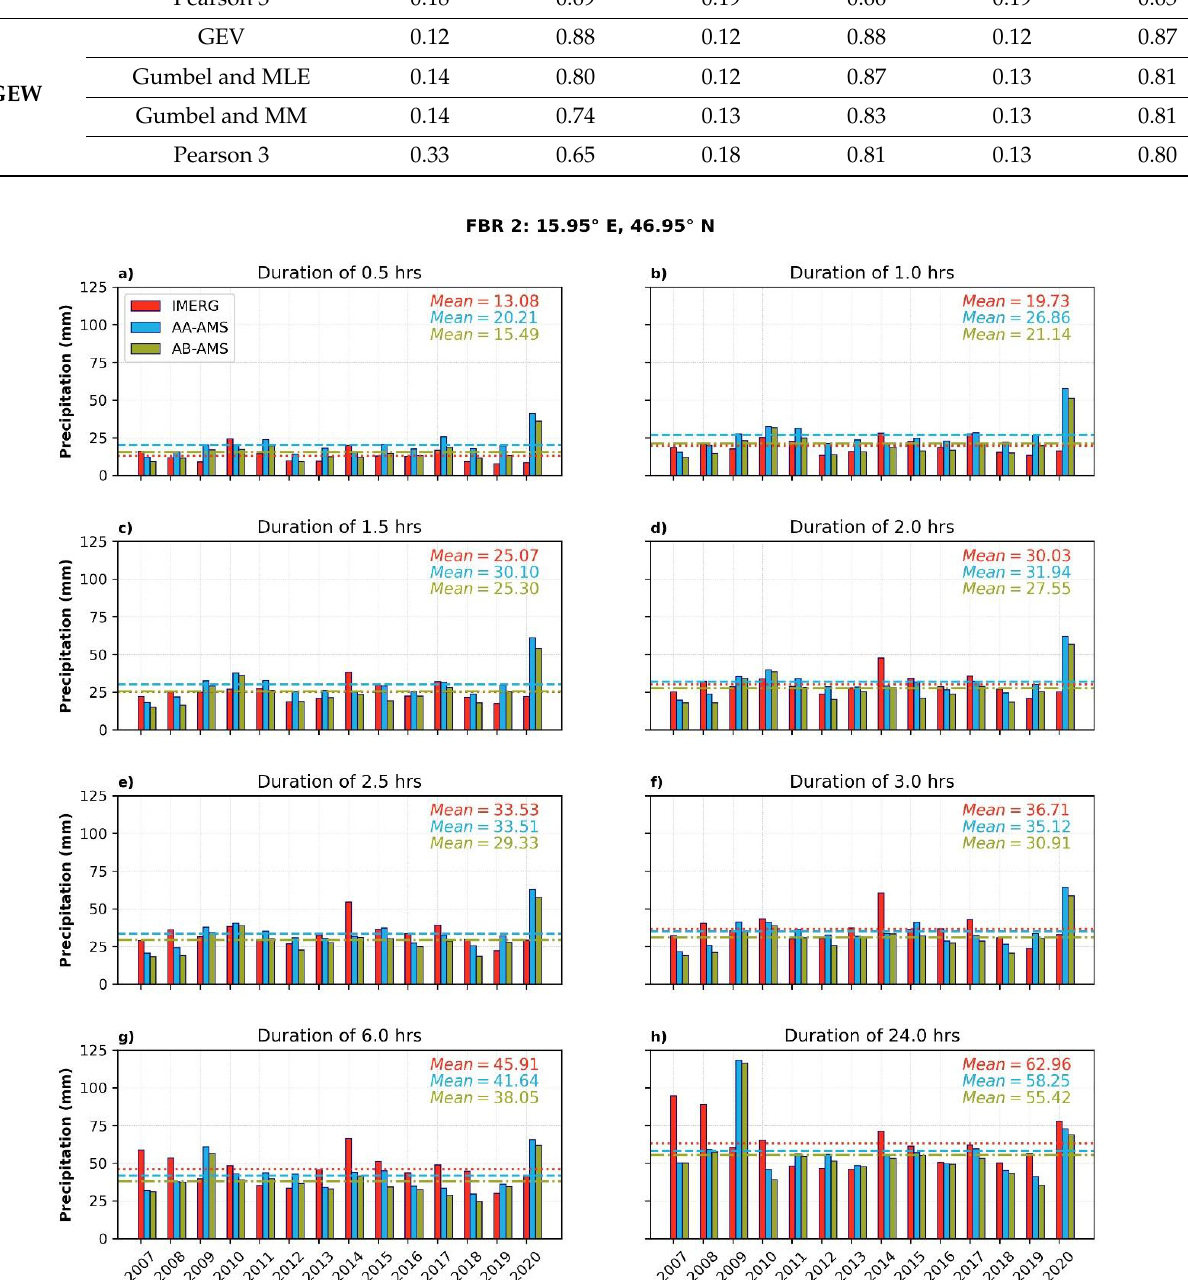
Figure 3. Annual maximum time series for FBR 2 by durations. The subfigures illustrate event durations of 0.5-h ( a ), 1-h ( b ), 1.5-h ( c ), 2-h ( d ), 2.5-h ( e ), 3-h ( f) , 6-h ( g ), 24-h ( h ). In all the subfigures, the red bars are the IMERG AMS, light blue bars are the AA-AMS, and the green bars are the AB-AMS. The dashed lines are the mean AMS for each case.